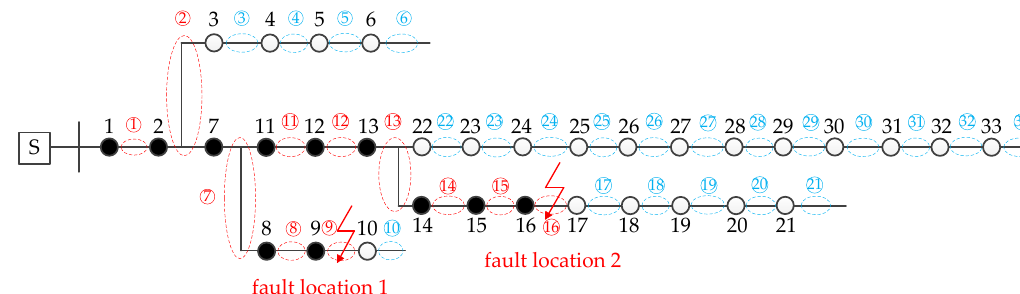
Figure 7. Multiple faults in the IEEE-33 node distribution network. Table 4. The line list of Figure 7.